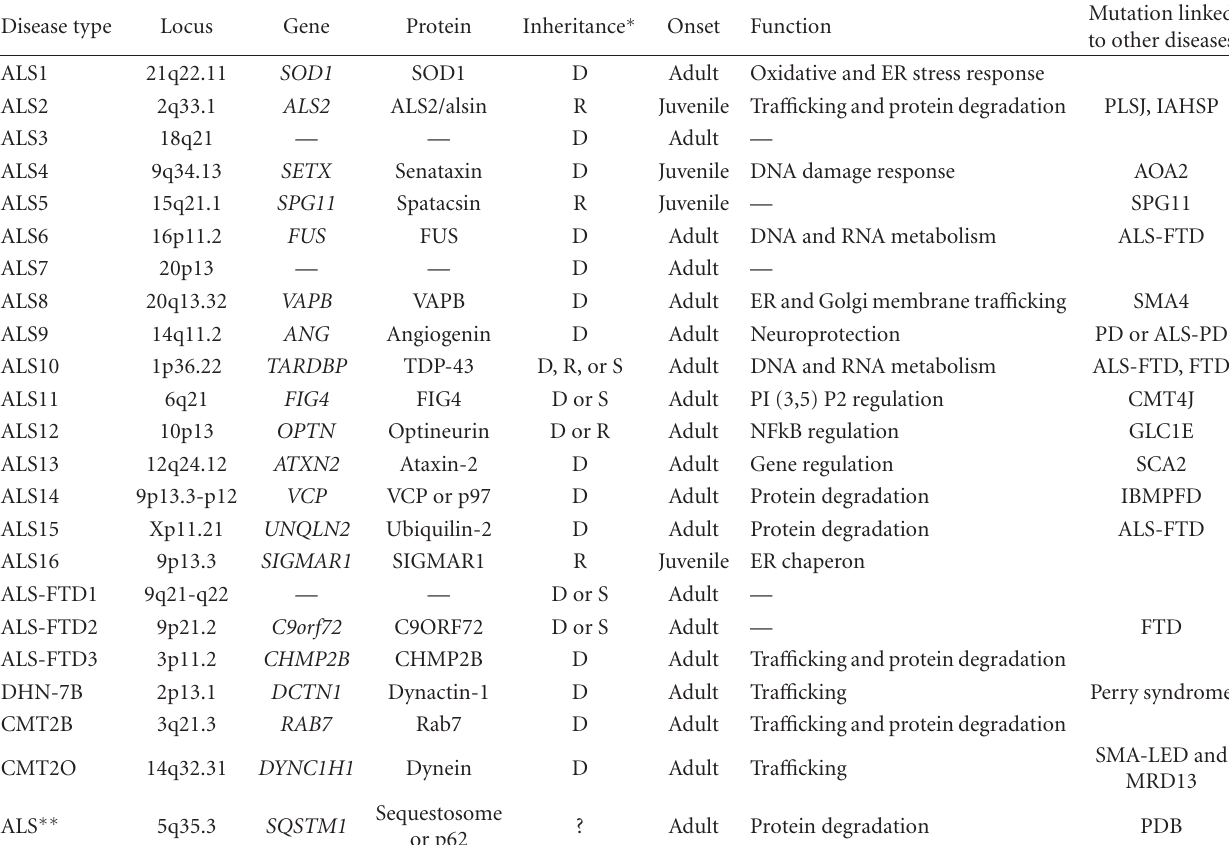
Table 1: Genes associated with ALS and other neurodegenerative diseases. Disease